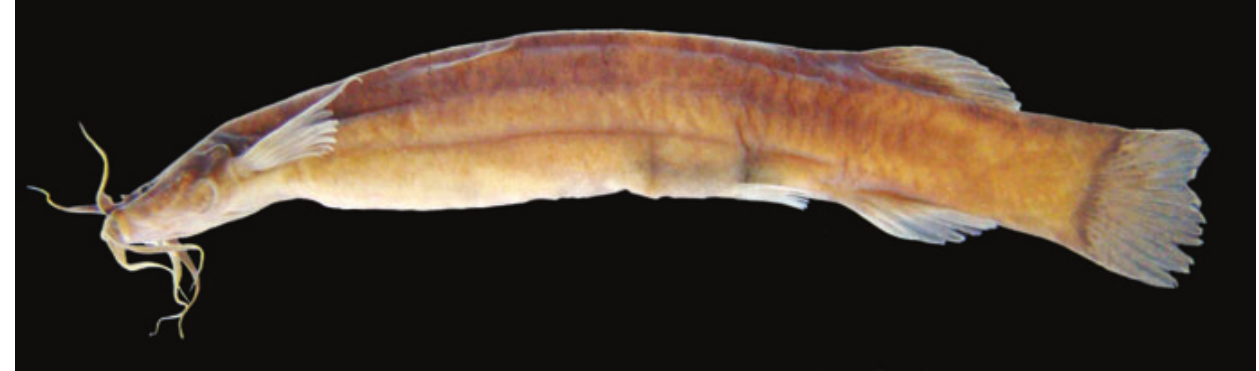
Fig. 1. Ituglanis ina , MPEG 19613, holotype, 62.0 mm SL, inverted lateral view of the right side; Brazil, Pará, Parauapebas, Serra dos Carajás, tributary of the Parauapebas, tributary of the rio